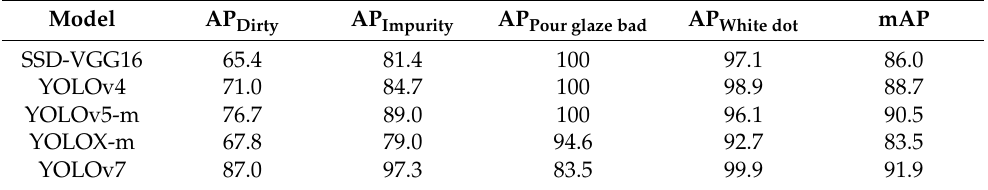
Table 3. The specific AP values for different categories of defects.